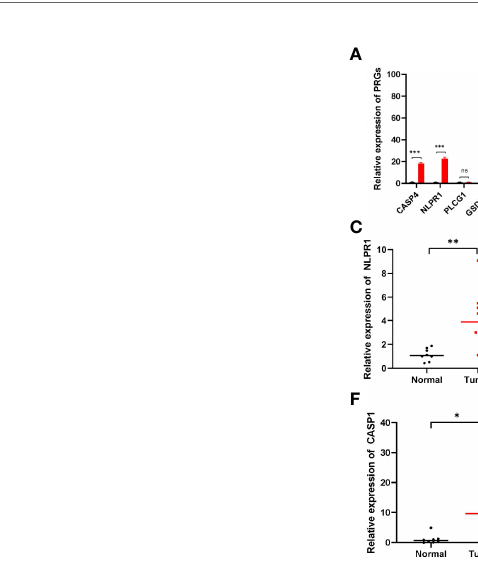
FIGURE 10 | qRT ‐ PCR showing the expression of prognostic PRGs in cells and tissues. (A) The expression of pyroptosis-related genes in PC cells. (B – H) The expression of PRGs in prognostic model in PC tissues. ns not signi fi cant; *p < 0.05; **p < 0.01; ***p <